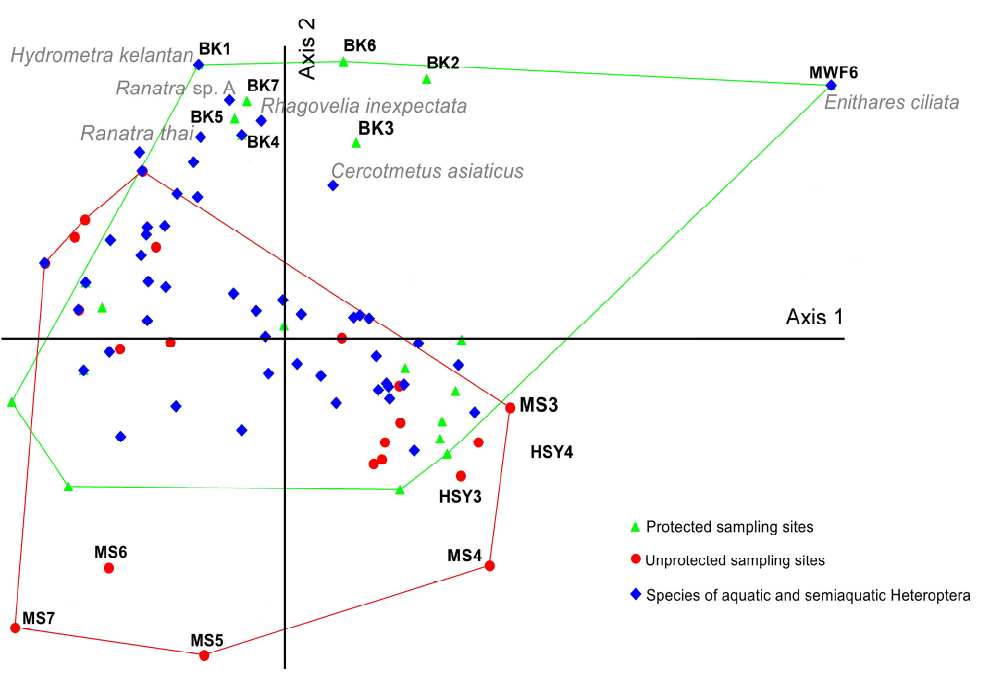
Figure 3. Species richness of protected and unprotected sampling sites during seven collecting events.